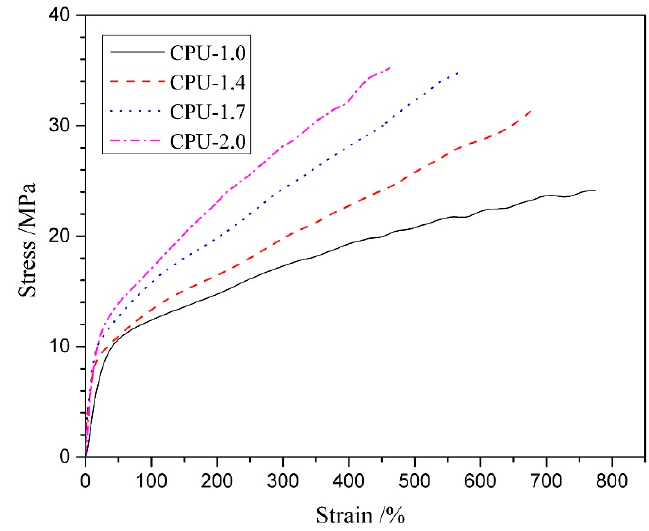
Figure 6. Stress–strain behaviors of CPU films with different COS content. Table 3. Mechanical properties of CPU films.